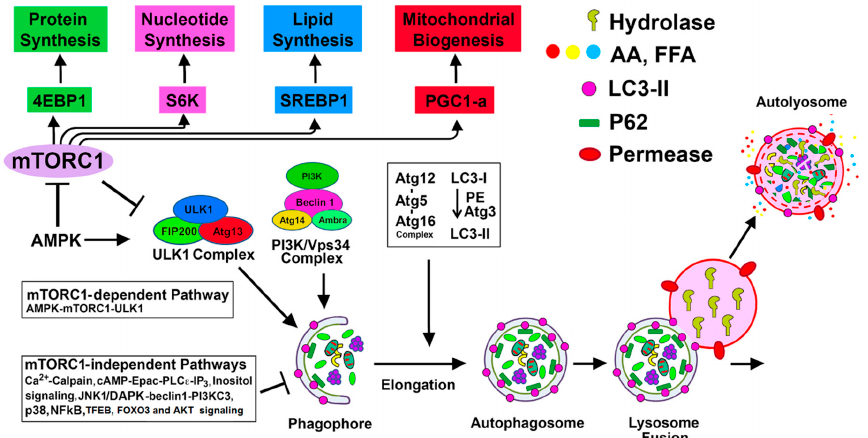
Figure 1. mTORC1-dependent and mTORC1-independent regulation of autophagy activation: Suppression of mTORC1 and induction of adenosine monophosphate activated protein kinase (AMPK) promote Unc-51 like autophagy activating kinase (ULK1) complex [ULK1, Atg13, focal adhesion kinase family interacting protein of 200 kD (FIP200), and Atg101] activation at the pre-autophagosomal assembly site (the certain domain of the ER) and initiates the autophagy process. Active ULK1 complex regulates the activity of the class III phosphatidylinositol (PtdIns) 3-kinase complex (including Beclin-1, Atg14(L)/barkor, Vps15, Vps34, and Ambra1) that generates phosphatidylinositol 3-phosphate (PI3P) rich domain. PI3P and PI3P-binding proteins (double FYVE domain-containing protein 1 (DFCP-1) and WIPI proteins) participate in the nucleation and associated membrane dynamics of the phagophore structure, the site of nucleation. Atg9 positive vesicles, that traffic from Golgi and endosomes and regulated by ULK1 complex, contribute to the formation of omegosomes and phagophores. Expansion and maturation of autophagosome from the phagophore structure require two ubiquitin-like conjugation systems that produce Atg12-Atg5-Atg16 oligomeric complex (Atg16 L1 complex) and lipidation of microtubule-associated protein 1A/1B-light chain 3 (LC3) (mammalian homolog of yeast Atg8) with phosphatidyl-ethanolamine (PE). WIPI upon binding to PI3P recruits Atg16 L1 complex to PI3P initiation sites. Atg12-Atg5 of the Atg L1 complex is then